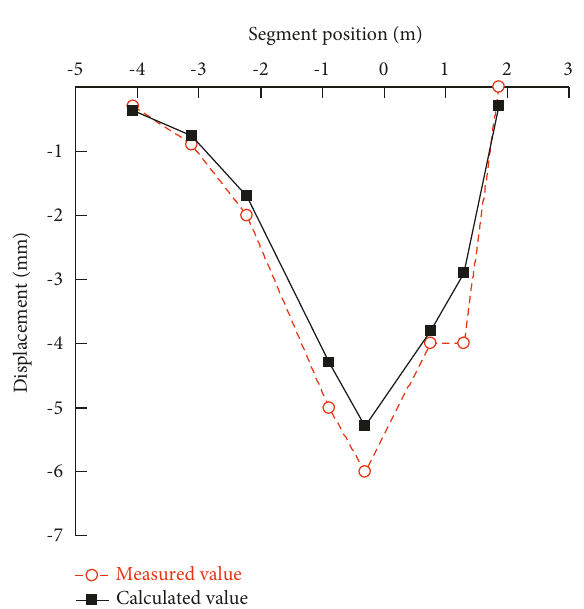
Figure 8: Comparing the calculated results with the measured